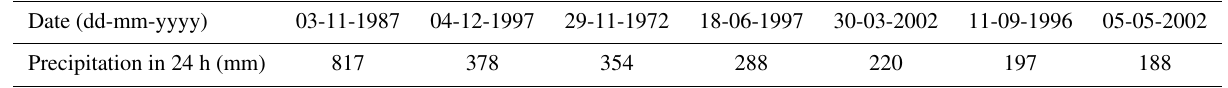
Table 2. Summary of recent (most relevant) flood events for the case study.